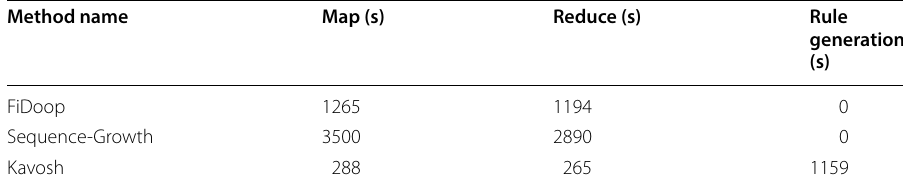
Table 16 Execution details